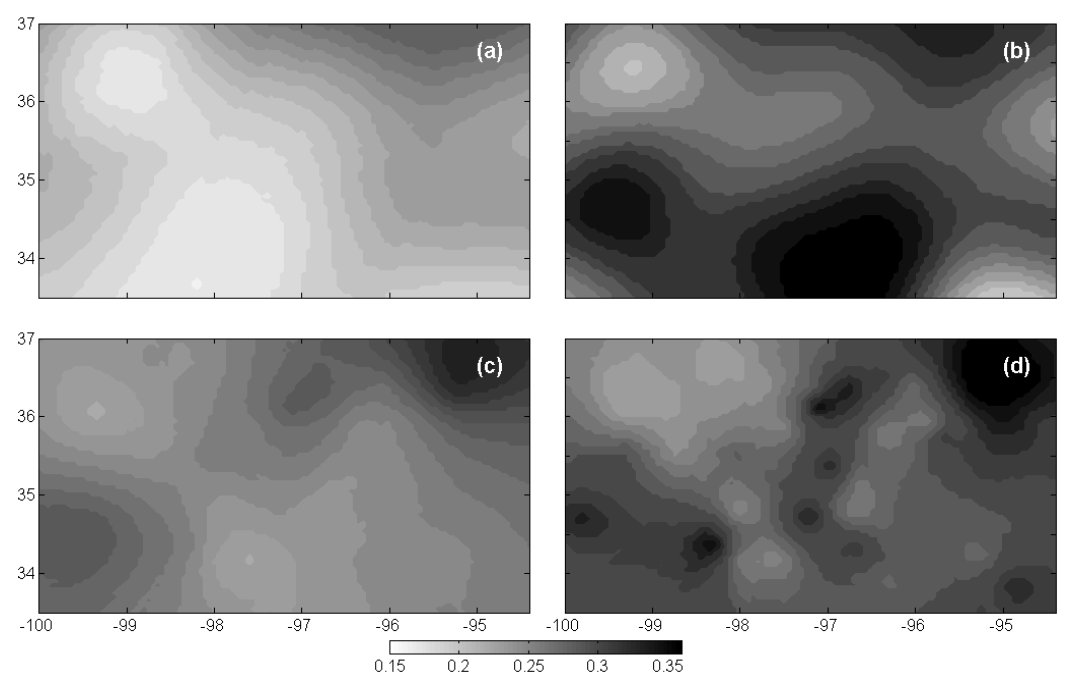
Figure 8. Kriged map of soil moisture for AGRMET data (a and b) and Mesonet